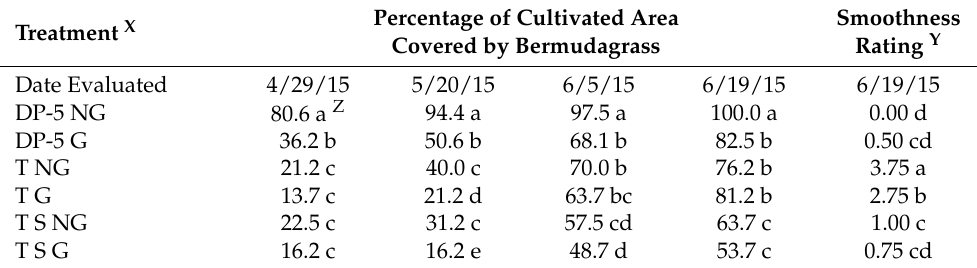
Table 2. Lawn recovery and evaluation of smoothness in the 2015 Lawn Recovery trial. Treatment X